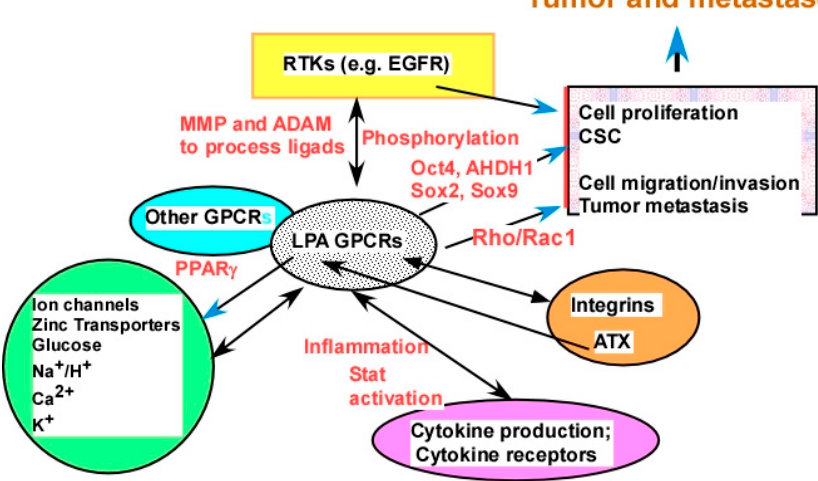
Figure 4. LPA cross-talk as potential targets. LPA interacts with major types of plasma membrane receptors, including ion channels, metal ion transporters, other transporters, receptor tyrosine kinases (RTKs), other GPCRs, integrins, and cytokine receptors. Examples from each category of receptors are discussed in the Section 2.2.4. Certain potential mechanisms of cross-talk are presented by words in red, including ligand production and/or processing, receptor phosphorylation, and production of downstream molecules mediating the cross-talk.